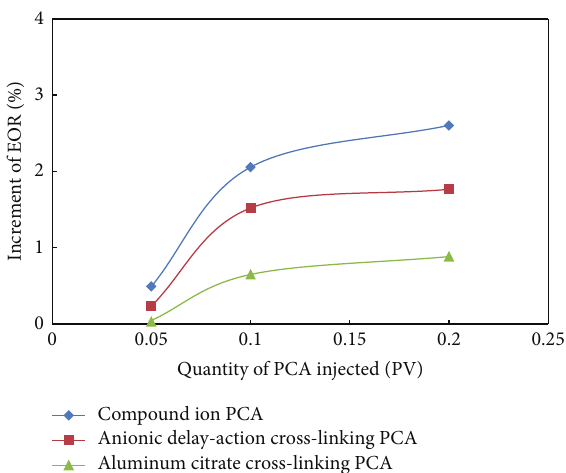
Figure 3: The relation between injected PV of PCA and recovery increment after polymer